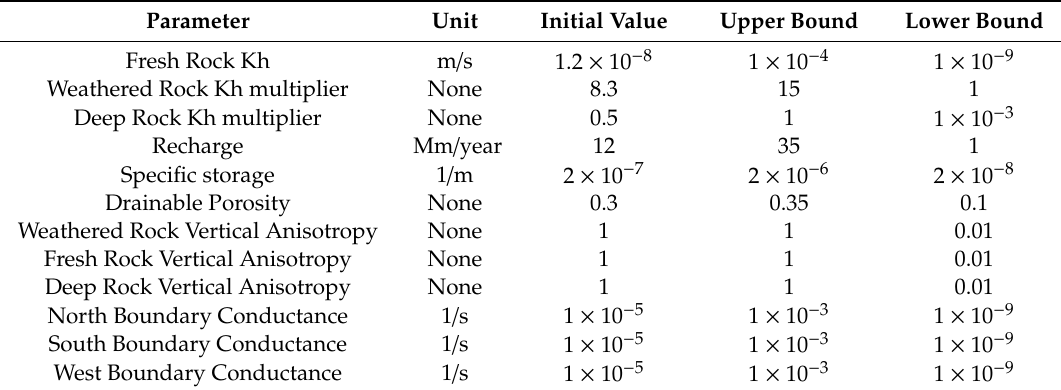
Table 4. Initial parameter values and